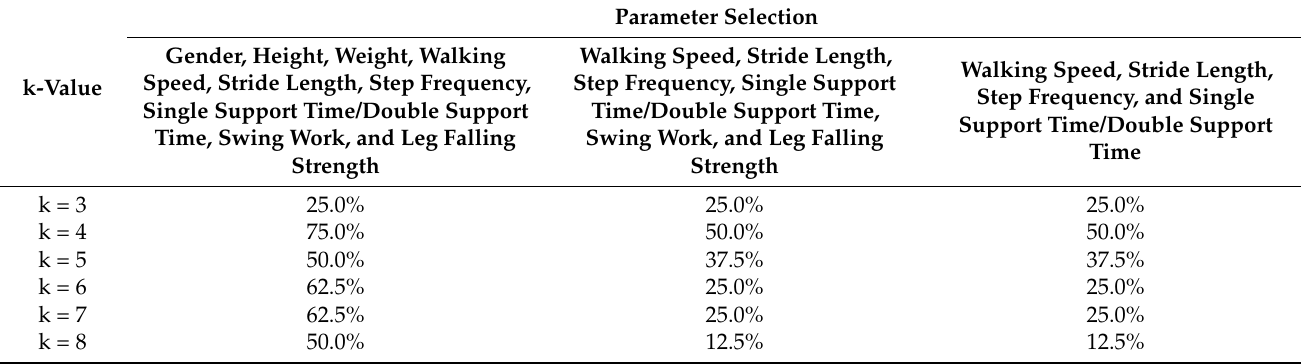
Table 4. Prediction accuracy of KNN classification algorithm with different parameters and k